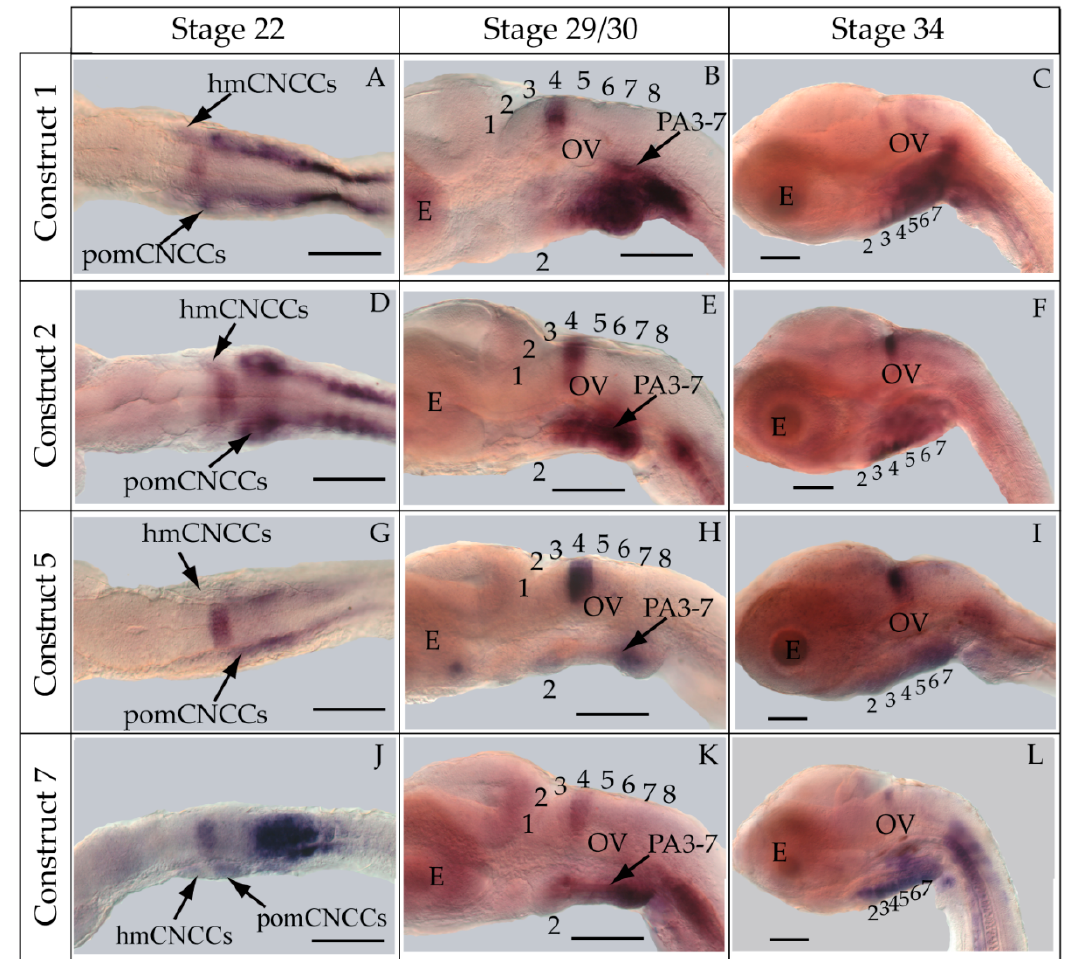
Figure 4. Whole-mount in situ hybridization of eGFP in stable-line hoxa2a UER(K20-RE5) transgenic medaka embryos generated with Construct #1 ( A – C ); Construct #2 ( D – F ); Construct #5 ( G – I ); and Construct #7 ( J – L ) at stages 22 (9 s) ( A , D , G , J ); 29/30 (72–84 hpf) ( B , E , H , K ); and 34 (121 hpf) ( C , F , I , L ). ( A , D , G , J ) Embryos were mounted with their anterior sides facing left and their dorsal sides facing the reader. ( B , C , E , F , H , I , K , L ) Embryos were mounted with their anterior sides facing left and lateral sides facing the reader. ( B , E , H , K ) Images are magnified to show rhombomere placement. Rhombomere numbers are indicated by black numbers above the dorsal sides of the embryos. Pharyngeal arches are indicated by black numbers below the ventral sides of the embryos. E, eye; hmCNCCs, hyoid migratory cranial neural crest cells; OV, otic vesicle; PA, pharyngeal arch; pomCNCCs, post-otic migratory cranial neural crest cells. Scale bars equal 0.1 mm.